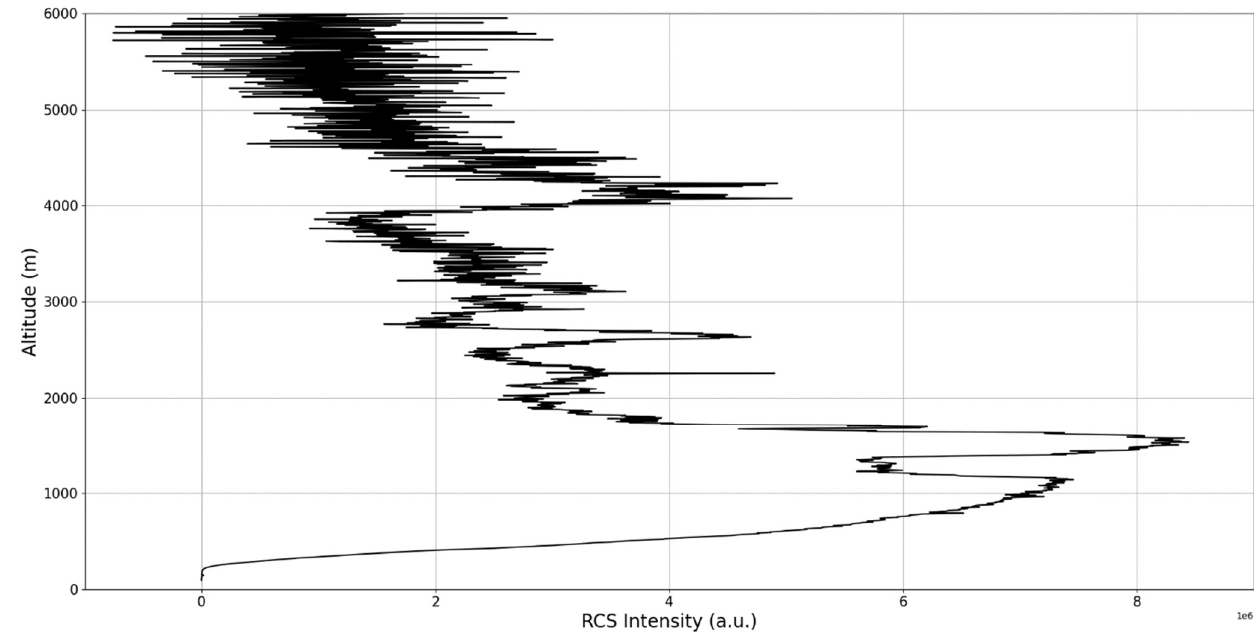
Figure 7. Zoomed-in RCS profile corresponding to point B.